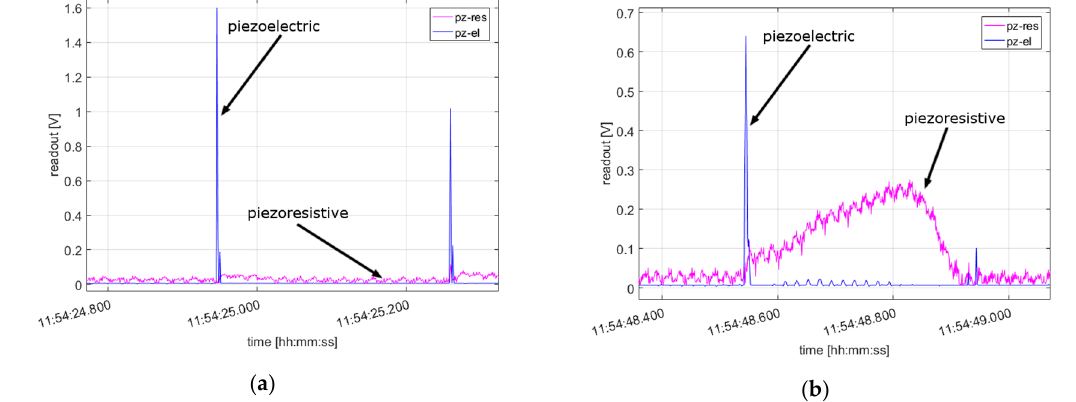
Figure 5. Detailed view of the results shown in Figure 4. ( a ) Tapping stimulus: the piezo-electric stage immediately reacts while the piezo-resistive response is negligible. ( b ) Normal pressure: the piezo- electric stage immediately reacts to the dynamic event (weight application) and then settles while the piezo-resistive stage takes time to provide a response proportional to the